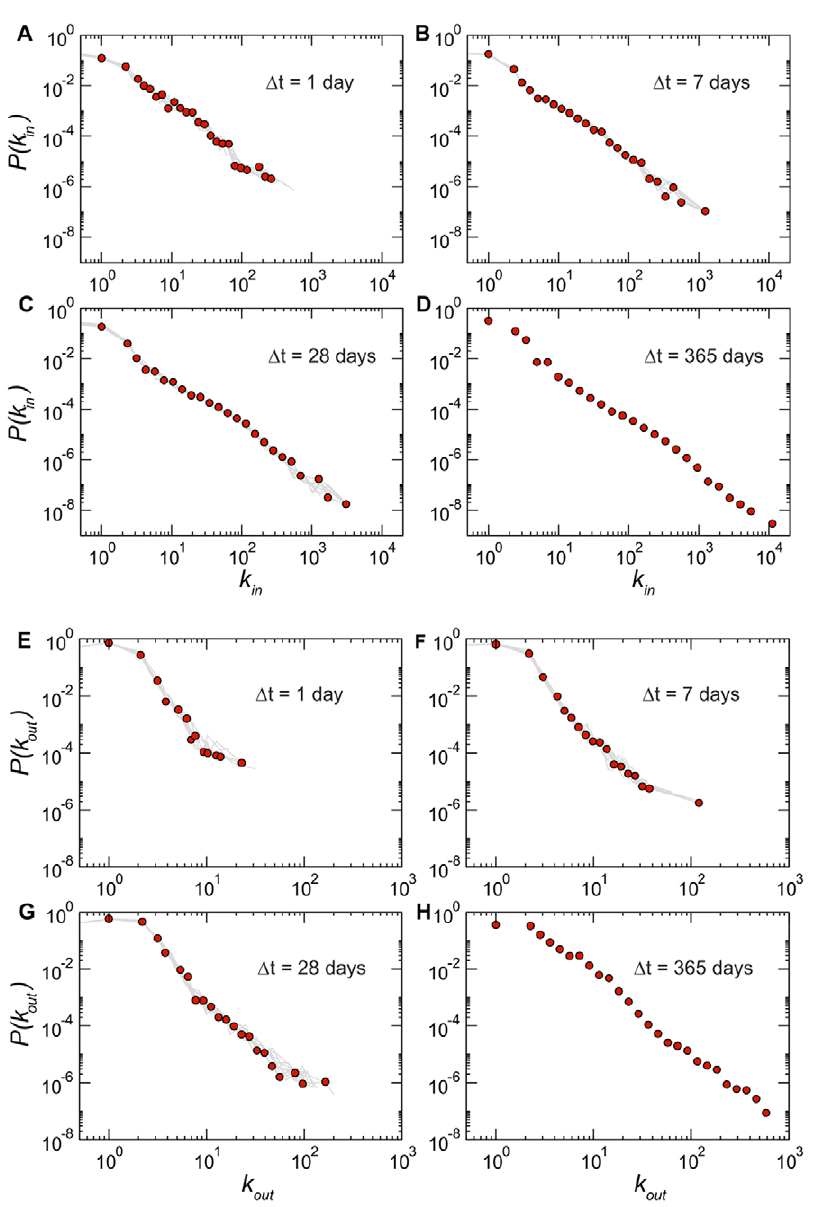
Figure 1. Degree distributions for networks aggregated on different timescales D t . Since a single value of D t (for D t v 365 days) yields multiple snapshots, each panel shows one distribution obtained for a given snapshot (circles) superimposed to a subset of the distributions obtained for the other snapshots at the same value of D t (grey lines). Panels A to D report the distributions of the in-degree k in , that show very large fluctuations and a power-law like behavior with exponent close to { 2 in all cases. Panels E to H present the distributions of the out-degree k out , characterized by a cut-off that strongly depends on the length of the aggregating time window.